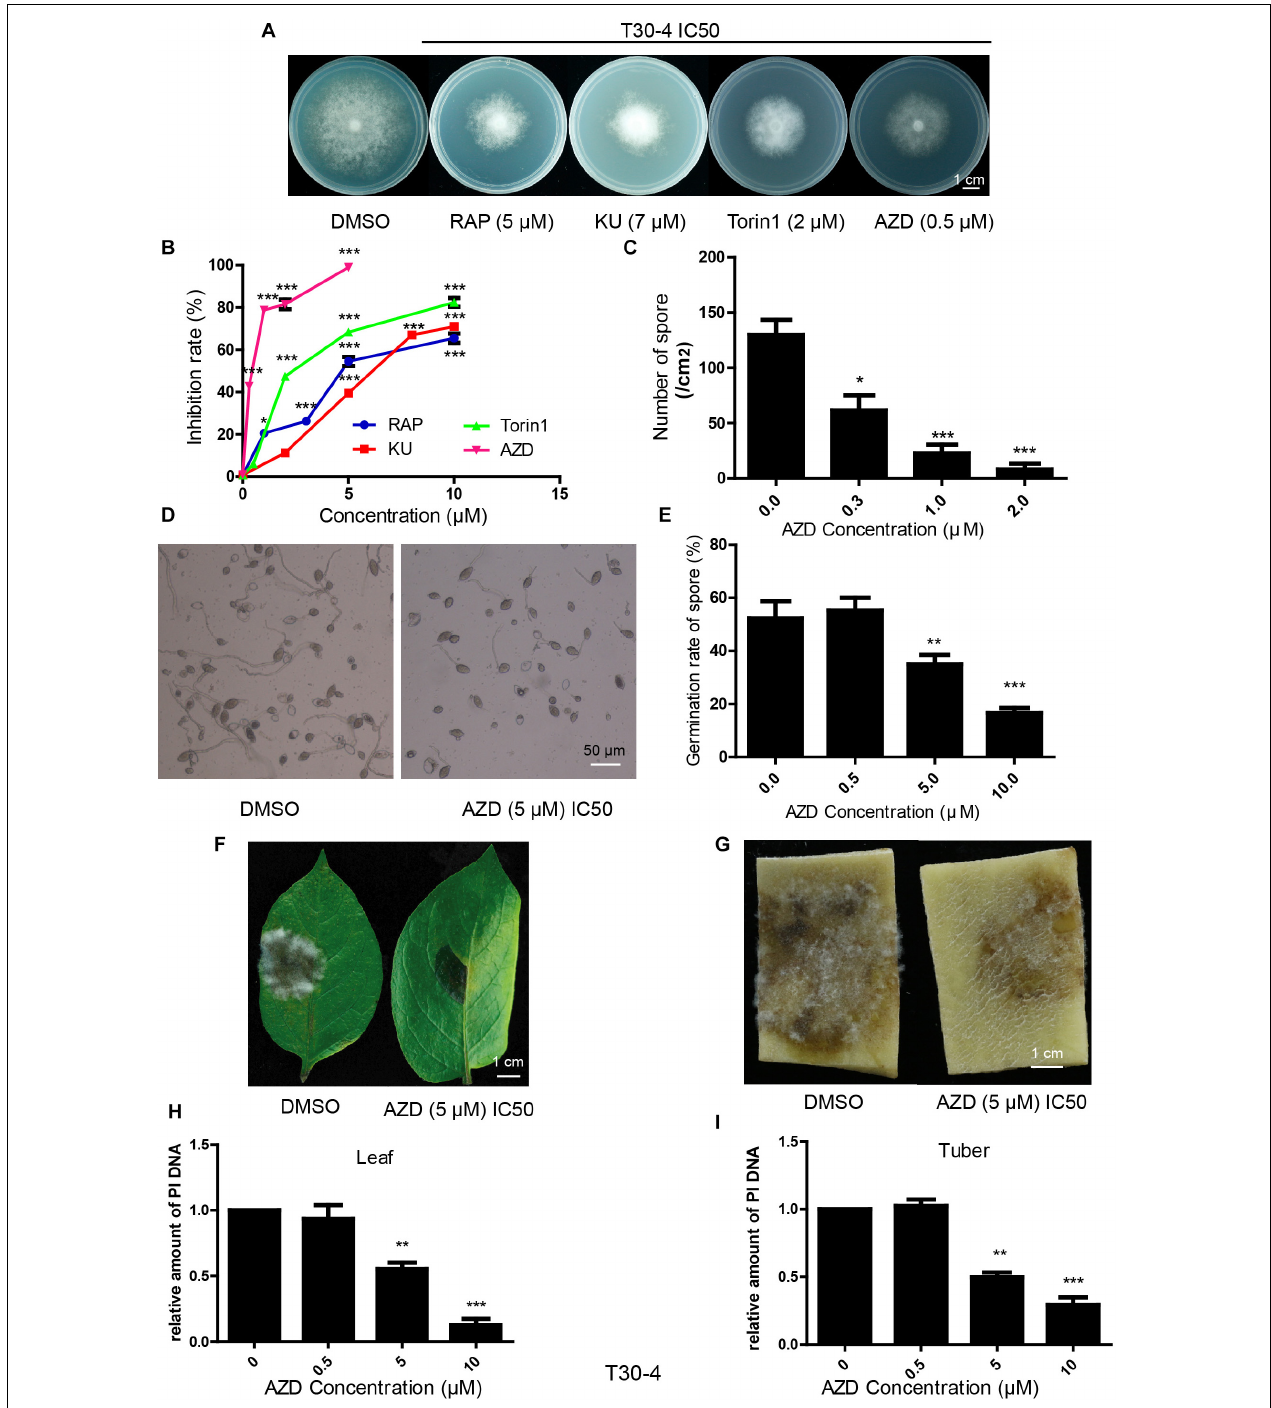
FIGURE 2 | TOR inhibitors inhibited P. infestans (T30-4). (A) Mycelial phenotypes of T30-4 treated with IC50 of RAP, KU, Torin1, and AZD for 14 days. (B) Mycelia growth inhibition rate of T30-4 treated with different concentrations of four TOR inhibitors. (C) Inhibitory effects of sporulation capacity treated with different concentrations of AZD. (D,E) Spore germination phenotypes or rates of T30-4 treated with different concentrations of AZD. (F,G) Disease symptoms on leaves and tubers were captured after inoculation with the T30-4 strain for 4 days. The leaves and tubers were inoculated with spore solutions pretreated with different concentrations of AZD. (H,I) P. infestans DNA (T30-4) in tubers or leaves was quantified after being inoculated by spore solutions. Spore solutions were pretreated with different concentrations of AZD. Data was normalized to the EF1 DNA levels of potato. (* P < 0.05, ** P < 0.01, *** P < 0.001).